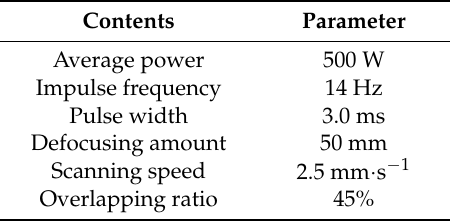
Table 1. Experimental process parameters of laser powder cladding (LPC).